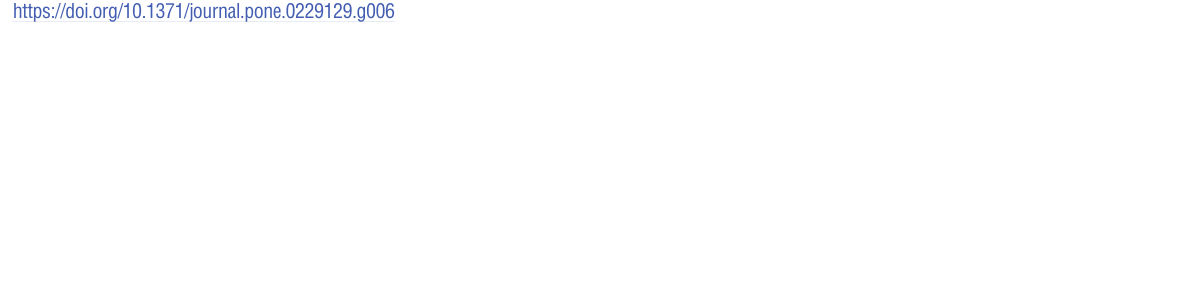
PLOS ONE | https://doi.org/10.1371/journal.pone.0229129 March 13,